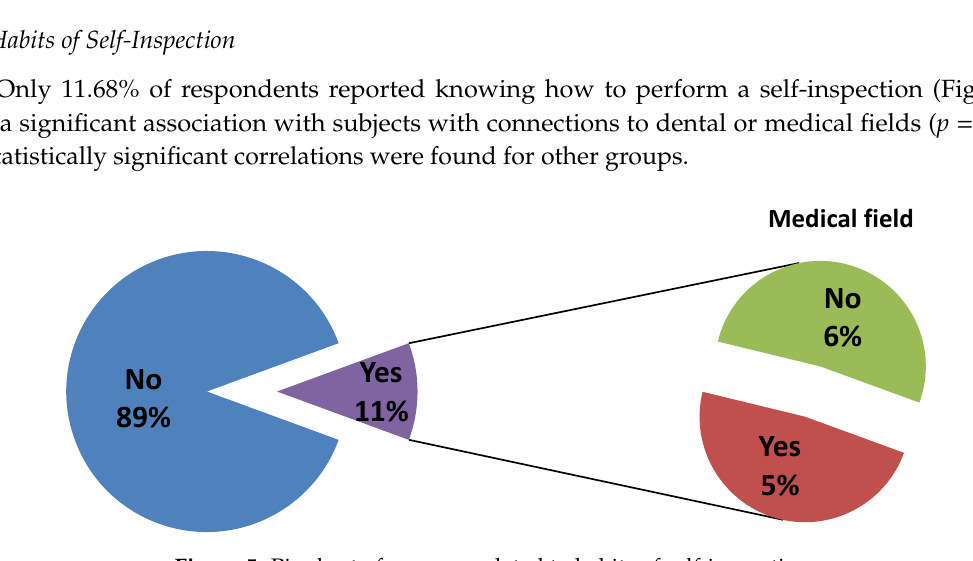
Figure 4. Pie chart of answers related to knowledge of features of OSCC.